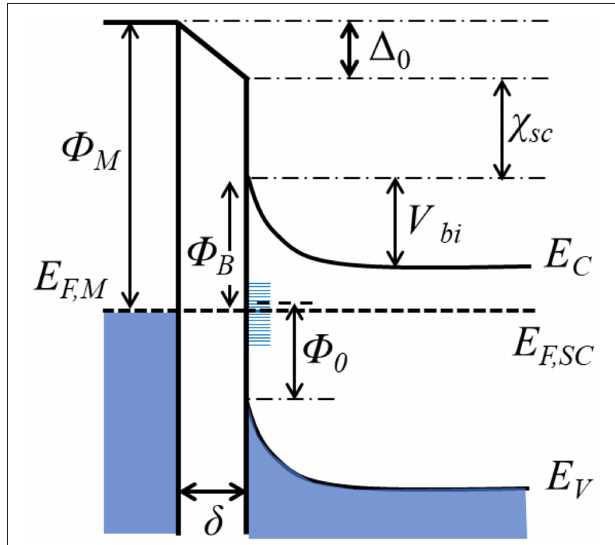
FIGURE 5 | Energy diagram of a metal-semiconductor( n -type) contact with an interfacial layer. Φ M , metal work function; E F , M and E F , SC , Fermi levels of the metal and semiconductor. χ SC : semiconductor electron affinity. E C , E V : Energy levels at the edges of the conduction and valence bands. Φ B : Schottky barrier height. V bi : built-in potential. δ : interfacial thickness. 1 0 : voltage drop across the interface. Φ 0 : energy change between the valence band edge and charge neutrality